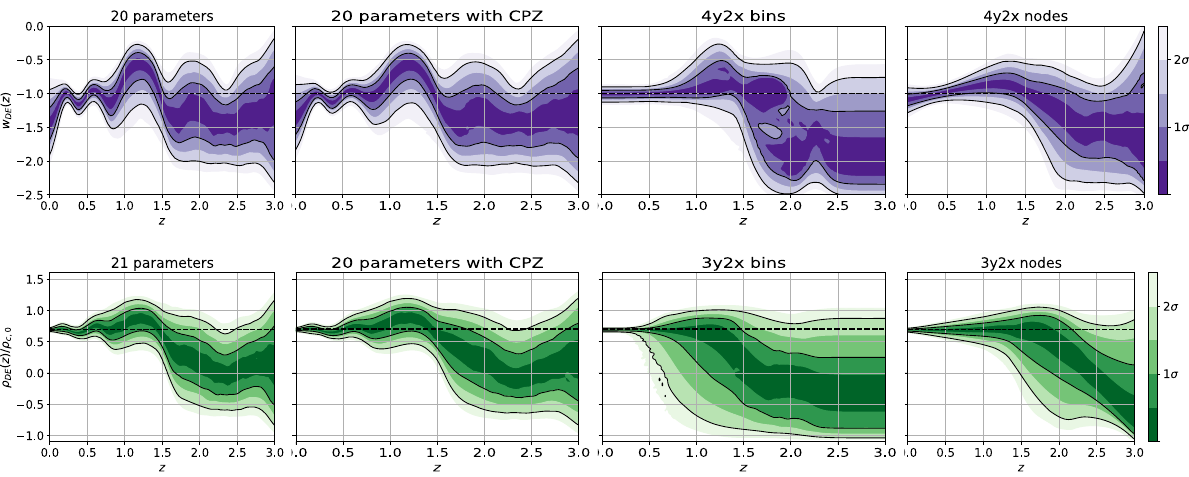
Fig. 5 From left to right: reconstructions with 20 bins, 20 bins with correlation function, internal z i -bins and internal z i -nodes. Purple figures correspond to the EoS whereas green to the energy density